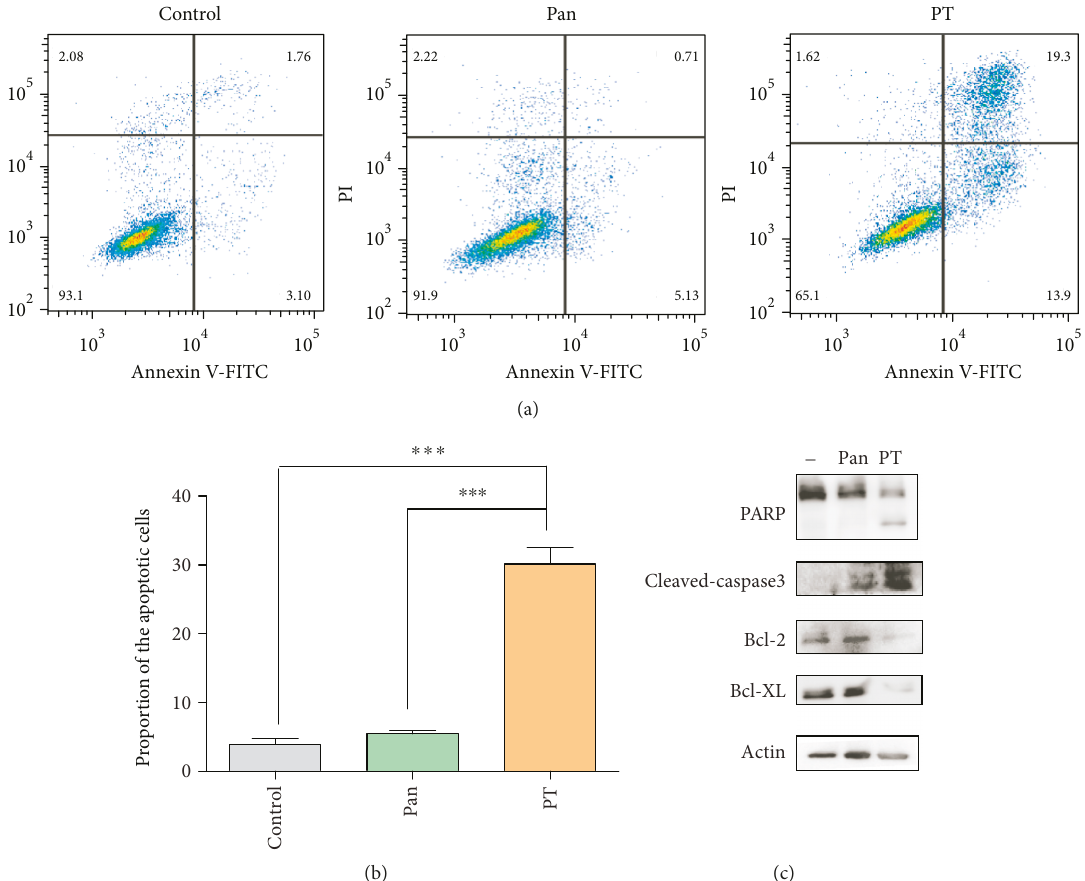
Figure 5: PT treatment resulted in caspase-3-dependent apoptosis in KYSE-450 cells. (a) Induction of apoptosis in KYSE-450 cells with medium alone (control), PT (10 nM), or Pan (10 nM) treatment for 16h. Apoptosis proportion was measured by fl ow cytometry. (b) Statistical analysis of the percentage of the apoptotic cells. Data was shown with mean ± SD. ∗∗∗ p < 0 001 . (c) Apoptosis-related protein (PARP, cleaved caspase-3, BcL-XL, or Bcl-2) was examined in KYSE-450 cells when treated with medium alone ( − ), Pan (10 nM), or PT (10 nM) for